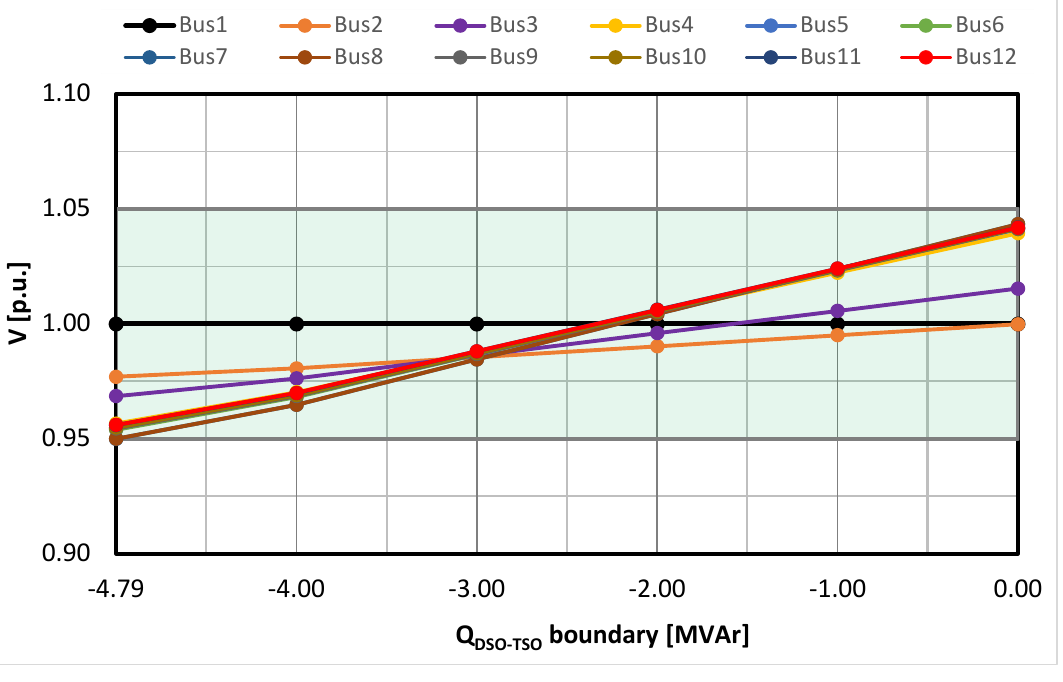
Figure 9. Nodes voltages for increasing TSO Q inductive needs.